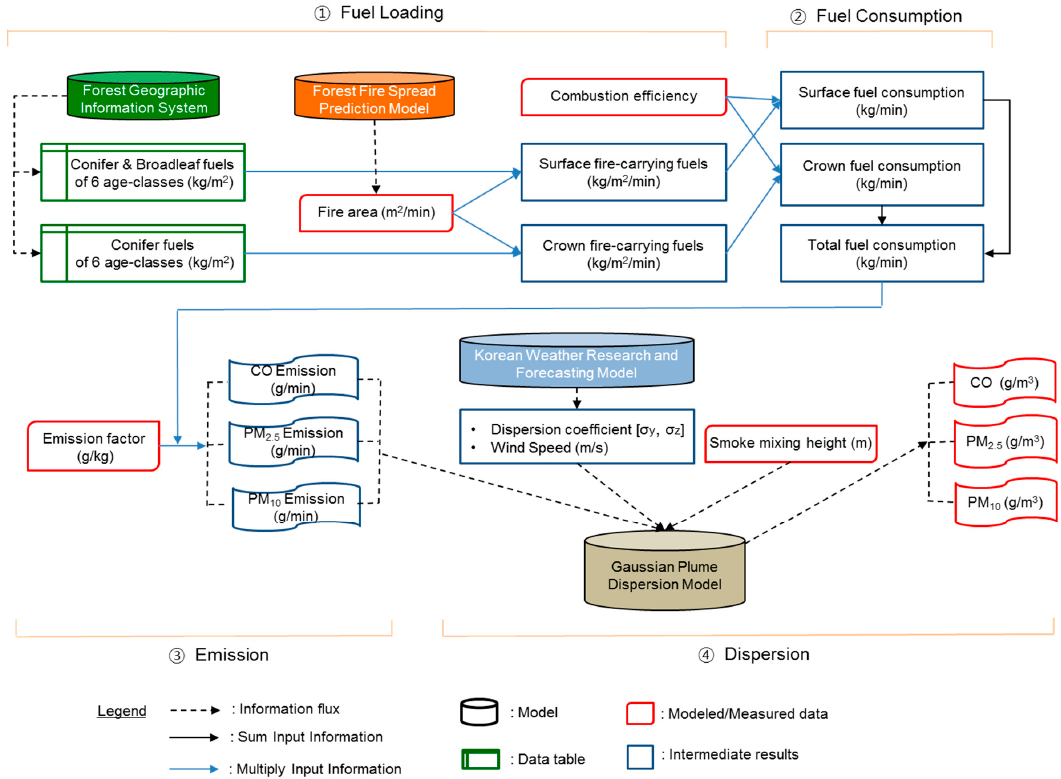
Figure 1. Integrated framework for predicting the smoke dispersion of CO, PM 2.5 , and PM 10 concentration using the Gaussian plume smoke dispersion model. PM 2.5 and PM 10 are fine (<2.5 µm) and coarse (<10 µm) particulate matter,